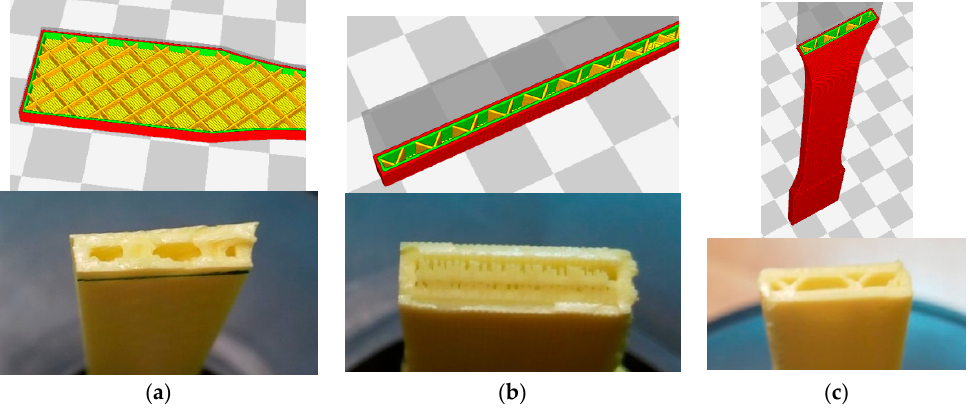
Figure 8. The detail of the infill and fracture surface in terms of orientation. ( a ) Orientation 1; ( b ) Orientation 2; ( c ) Orientation 3.